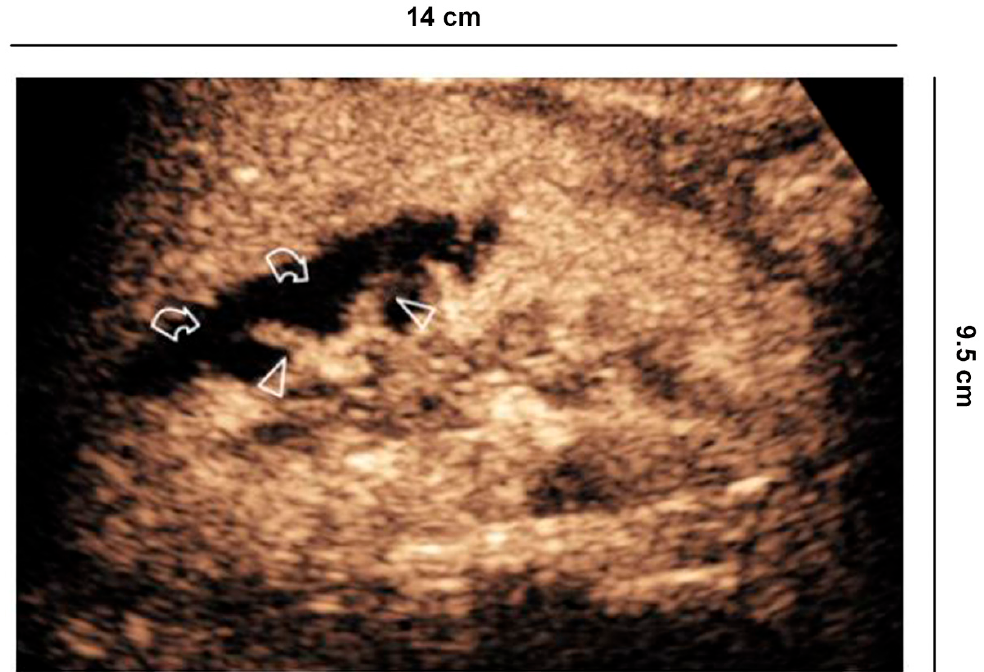
Figure 8. Vascular lesions. 56 years old man with atrial fibrillation shows creatinine elevation and right lower back pain. CEUS demonstrates focal acute cortical ischemia (curved arrow) and patent interlobar vessels (arrowheads).